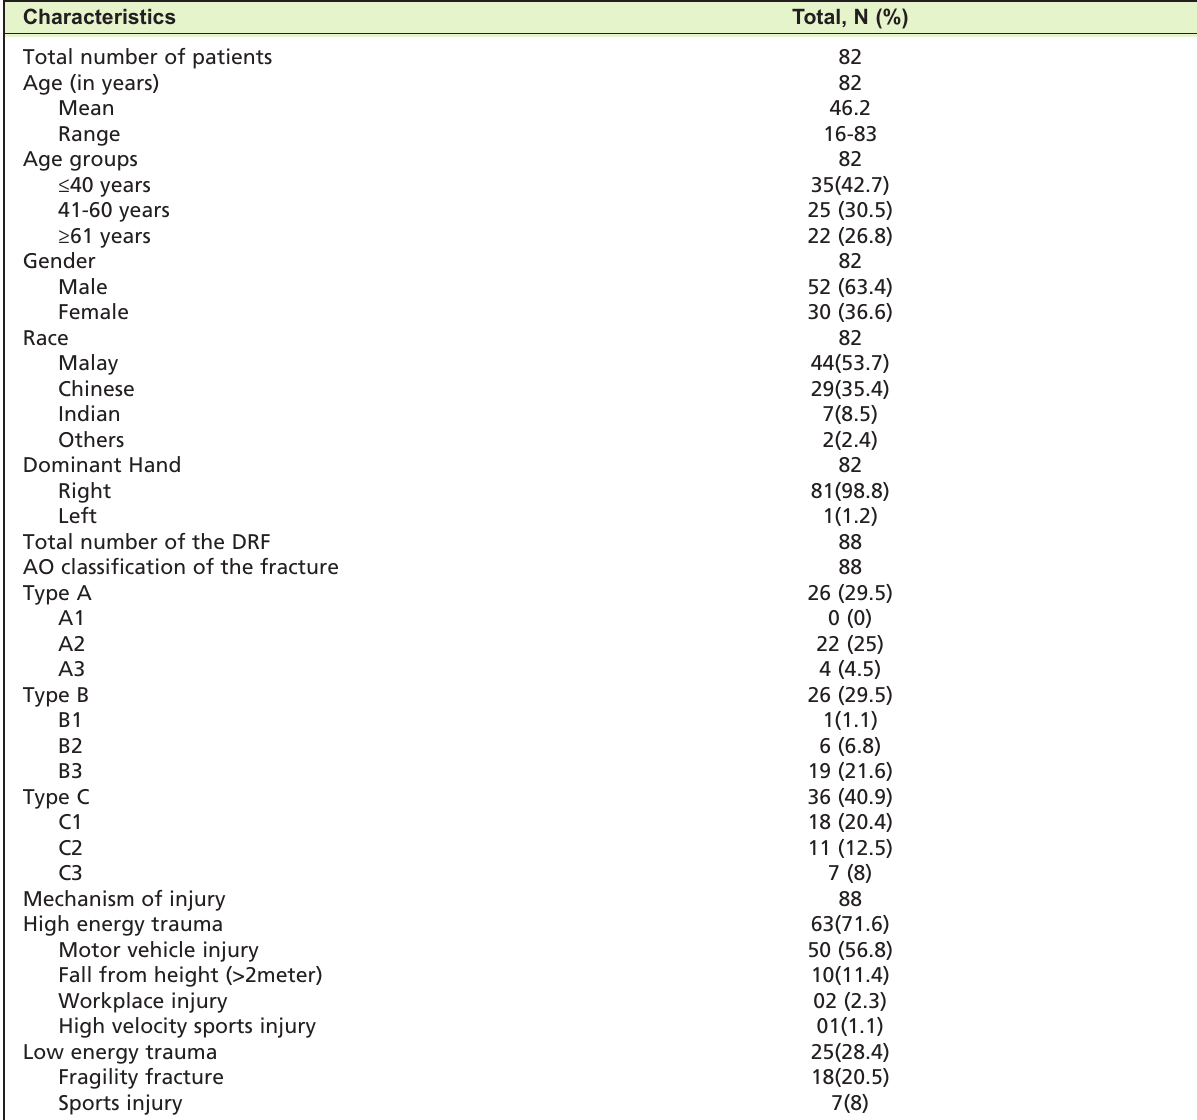
Characteristics of the study population Table I: